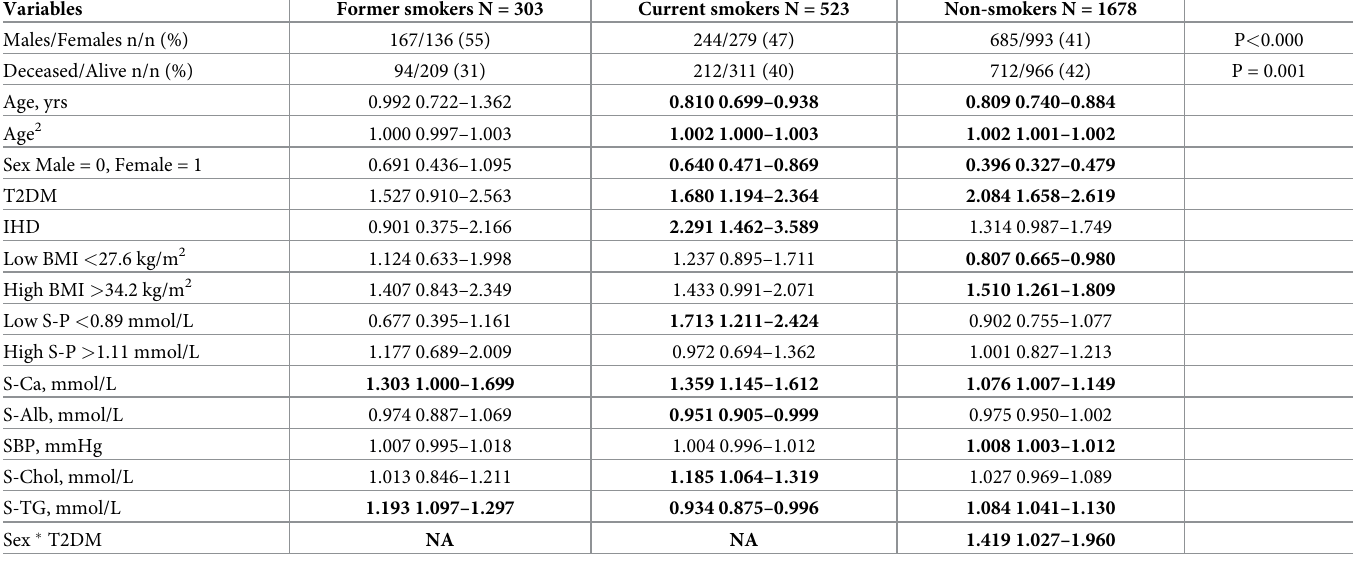
Table 4. Cox regression (HR; 95%CL) for all-cause mortality in former, current and non-smokers.